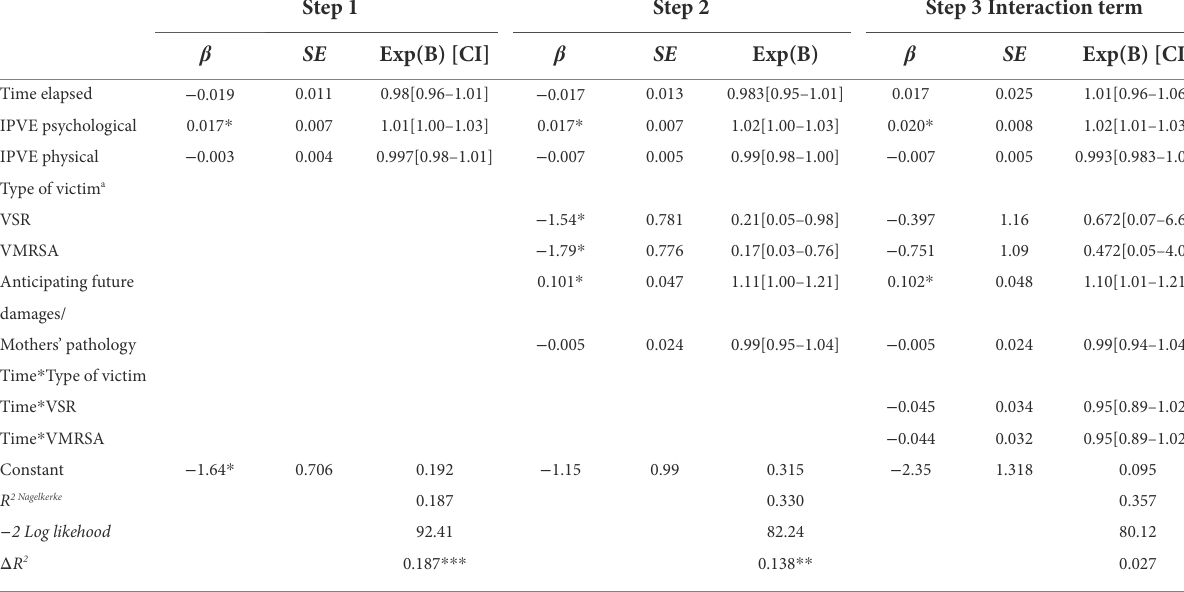
TABLE 4 Hierarchical logistic regression models predicting children’s pathological depression after IPV